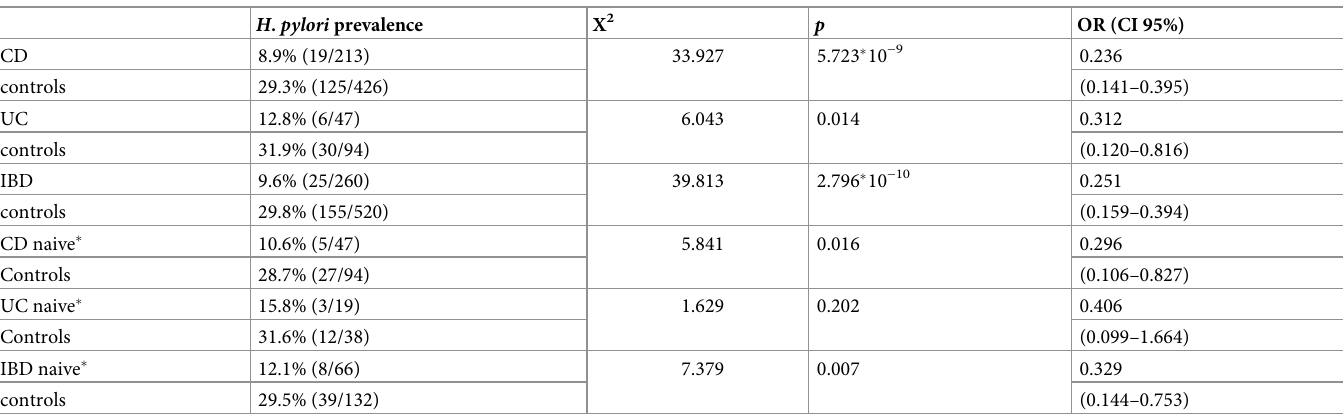
Table 2. H . pylori status in IBD patients and